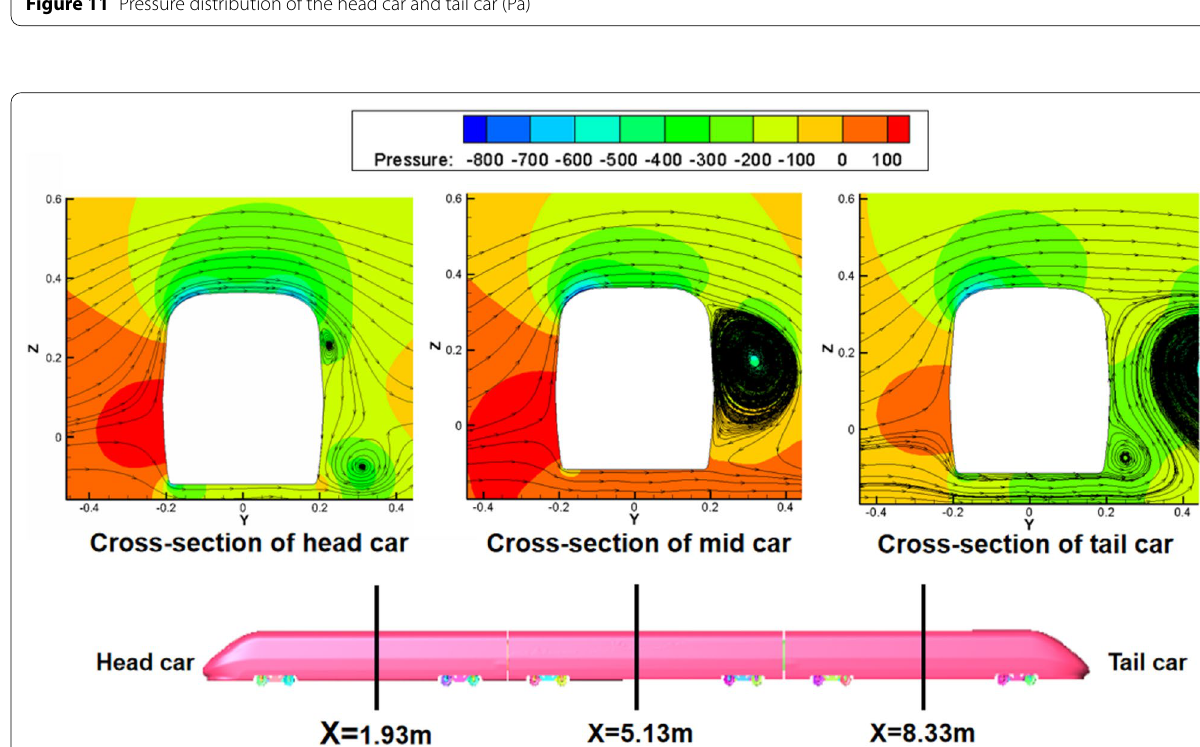
Figure 12 Streamlined distribution of each